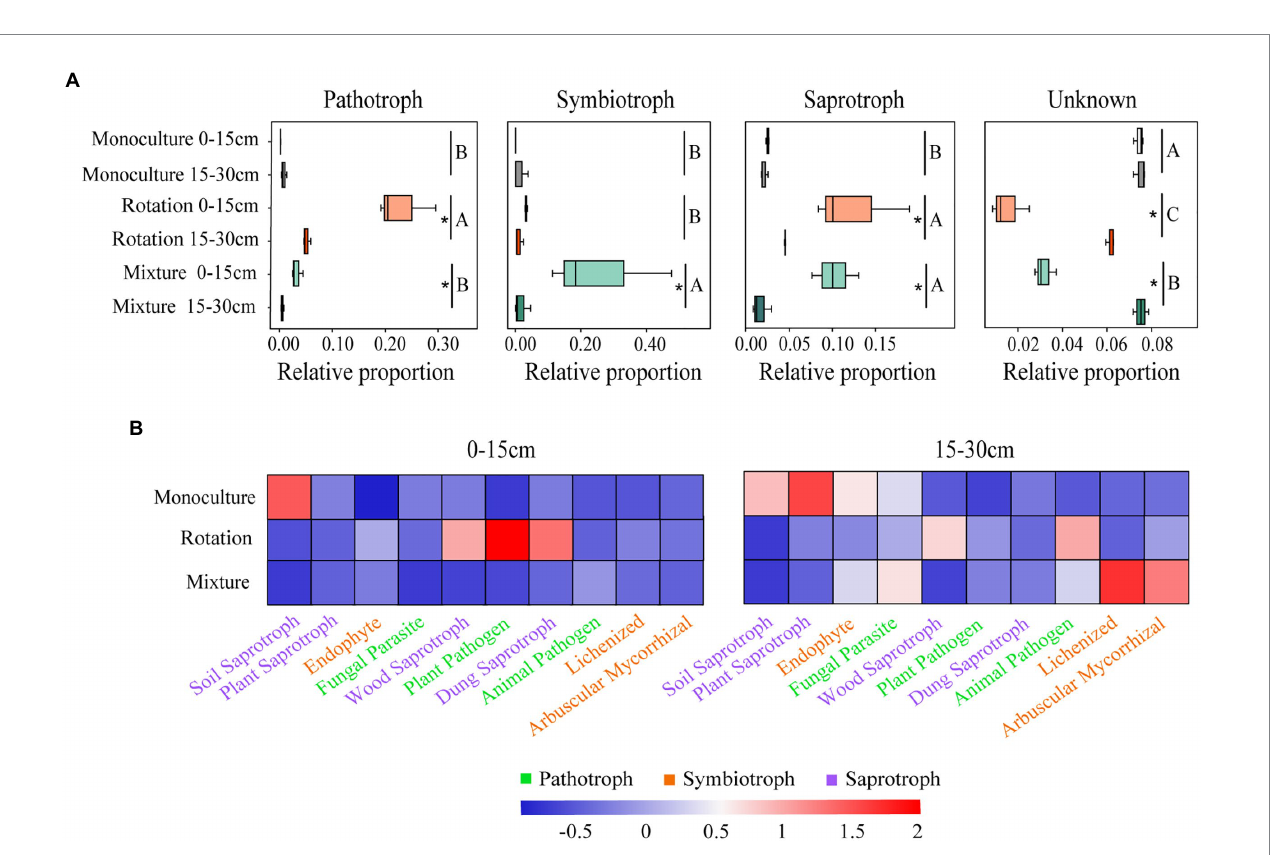
FIGURE 6 Variations in fungal function (A) and composition of fungal functional groups (guilds) inferred by FUNGuild (B) . Different letters indicate significant differences between groups ( p < 0.05). A significant difference between soil depths and statistical significance is indicated as follows. * p ≤